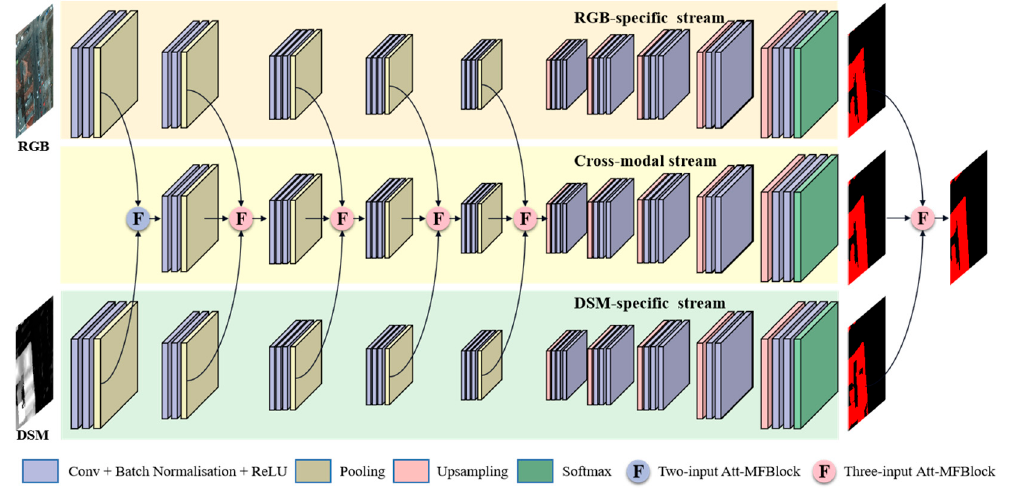
Figure 2. An overview of the hybrid attention-aware fusion network (HAFNet).